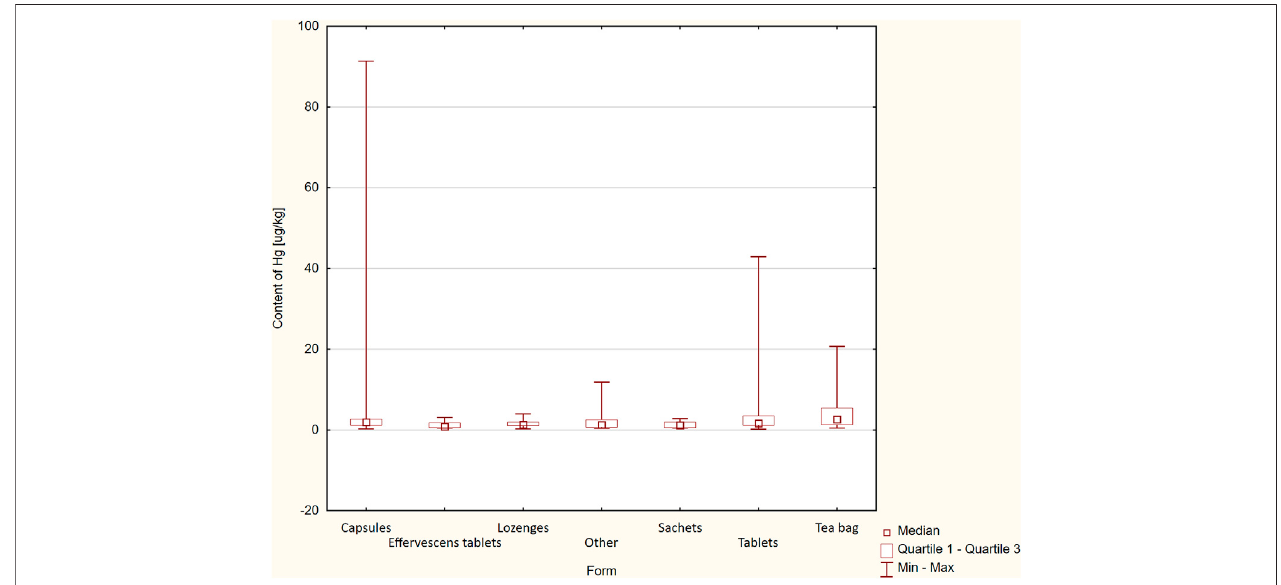
FIGURE 2 | Differences in Hg content between forms of DS ( p (cid:1) 0.045).